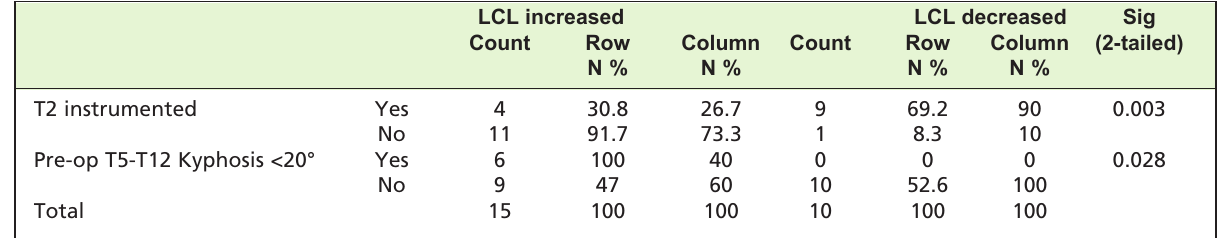
Table III: T2 instrumentation and T5-T12 kyphosis relationship with LCL change LCL